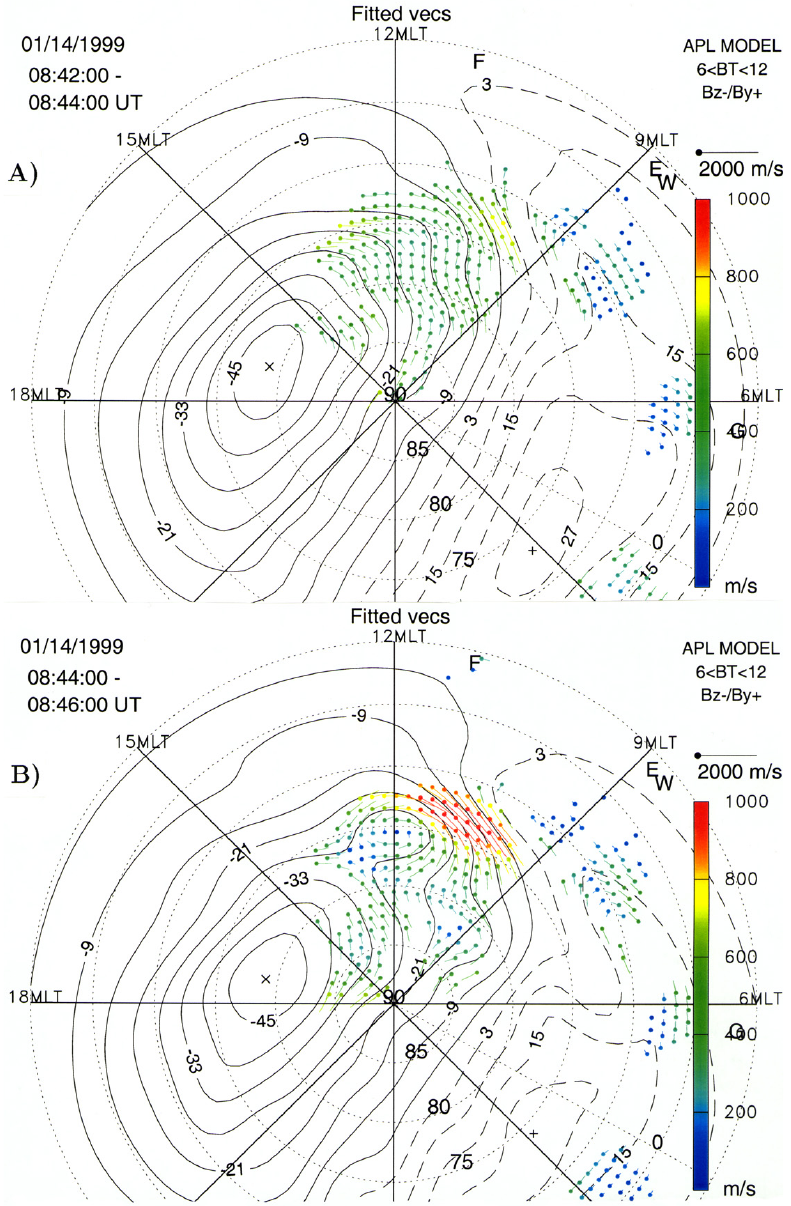
Fig. 14. Panels A, B, C, and D show SuperDARN vector plots for the intervals 08:42–08:44, 08:44–08:46, 08:46–08:48, and 08:48–08:50UT, respectively. Same format as in the previous figure. The MSP field of view and the approximate latitudinal extent of the aurora are marked by double-arrowed meridional line and bars, respectively, in panels C and D (Fig. 14 continues). tion pattern on the